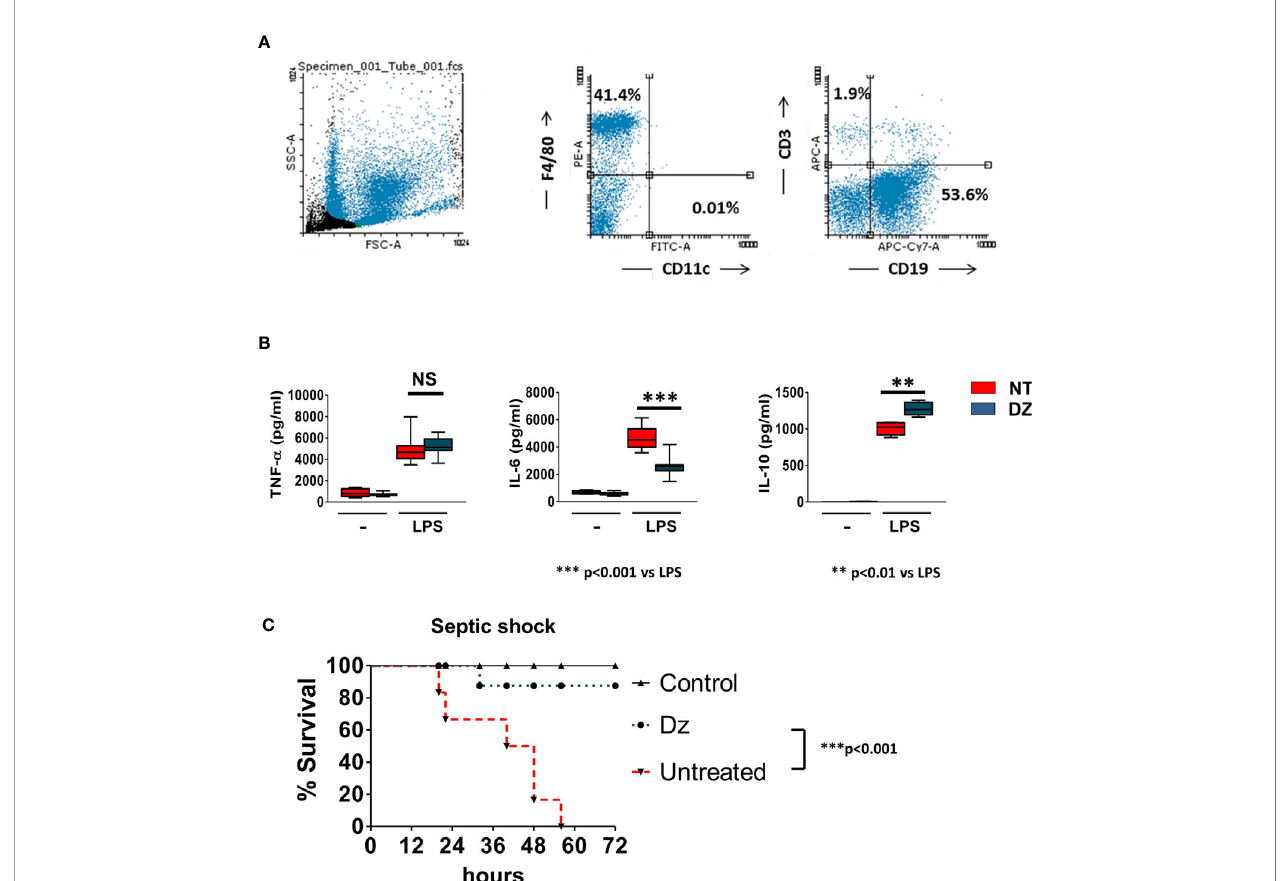
FIGURE 2 | Diazepam (DZ) protects mice from LPS-induced septic shock. (A) Peritoneal cells (PCs) from untreated control mice were obtained, stained with F4/80 (PE), CD11c (FITC), CD3 (APC), and CD19 (APC-Cy7) and then were evaluated by fl ow cytometry. (B) DZ-treatment modulates the activation and cytokine pro fi le of peritoneal cells (PCs). PCs from untreated or DZ-treated mice were obtained after 12 h of the last DZ injection and challenged in vitro with LPS during 18 h. TNF- a , IL-6, and IL-10 production by was measured in supernatants by ELISA. Data are representative of two independent experiments (n = 3). p was calculated by Student ’ s t -test for grouped samples and the probability of signi fi cance with respect to the untreated control is indicated by NS: not signi fi cant, ** p < 0.01, *** p < 0.001. (C) C57BL/6 mice were treated with three doses of DZ (2 mg/kg) or PBS administered in alternate days, and 12 h after the last treatment, the mice were i.p. injected with 800 m g of LPS. Control non-treated unchallenged mice ( ▲ ), PBS-treated LPS-challenged mice ( ▼ ), DZ-treated LPS-challenged mice ( ● ). Data are representative of two independent experiments (n = 6). Statistical analysis was performed using log-rank test. ***p < 0.001 between PBS-treated and DZ-treated LPS-challenged mice. Non-signi fi cant values are expressed as